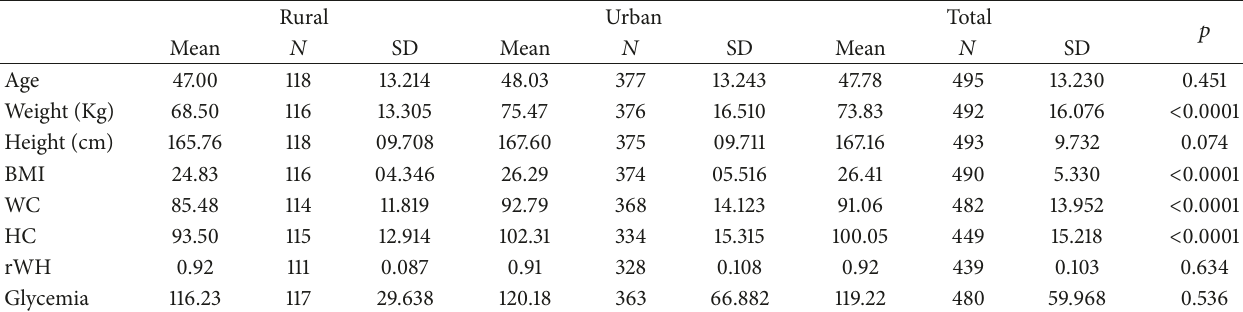
Table 3: Description of continuous variables of 495 hypertensive subjects in rural and urban setting in Mali.